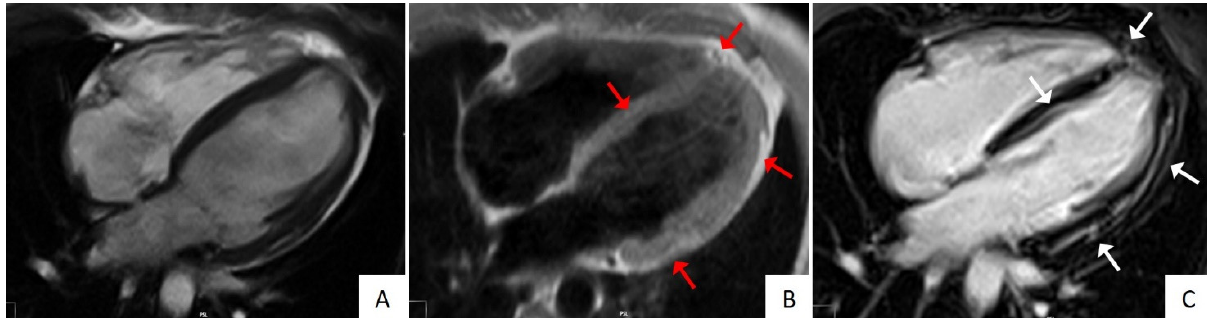
Figure 4. Cardiac magnetic resonance (CMR) imaging features of a patient affected by biventricular arrhythmogenic cardiomyopathy. Cine CMR imaging showing a mildly dilated left ventricle (LV) (Panel A ) with a slightly reduced systolic function (not showed). T1-weighted CMR images demonstrating fatty infiltration at the right ventricle apex, lateral, and septal LV walls (Panel B , red arrows). Post-contrast CMR images showing biventricular LGE in the same locations as in Panel B (Panel C , white arrows).